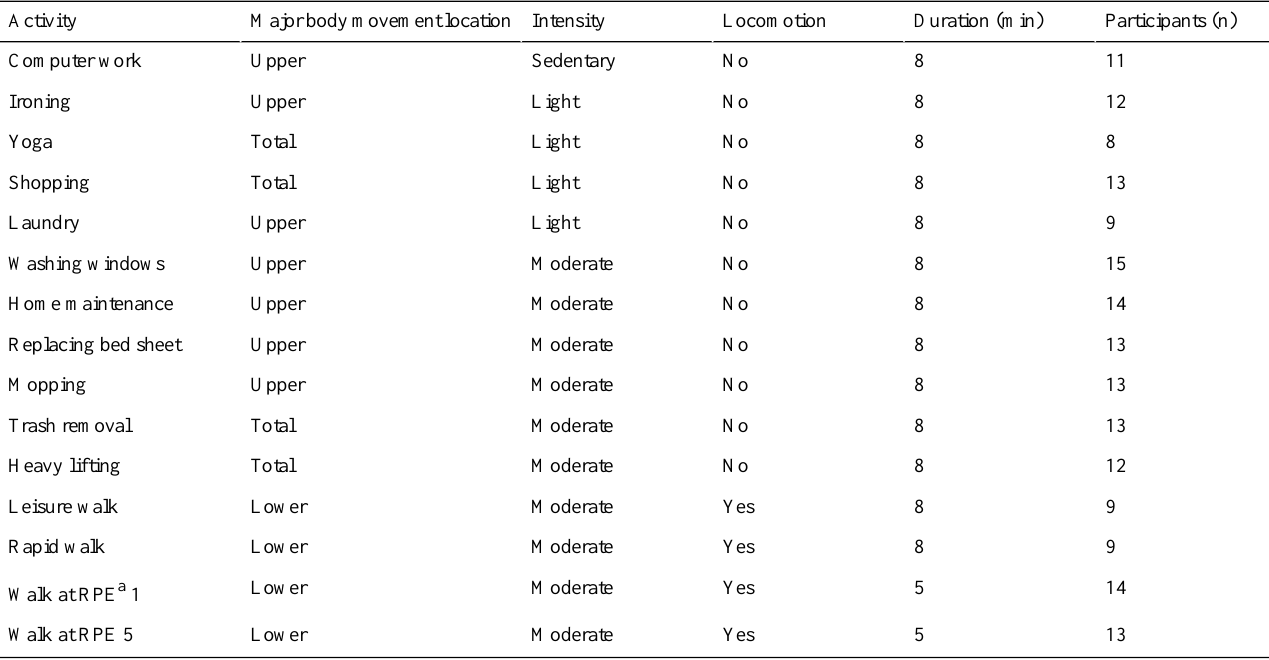
Table 2. Characteristics of each activity. Accelerometer data were collected from 40